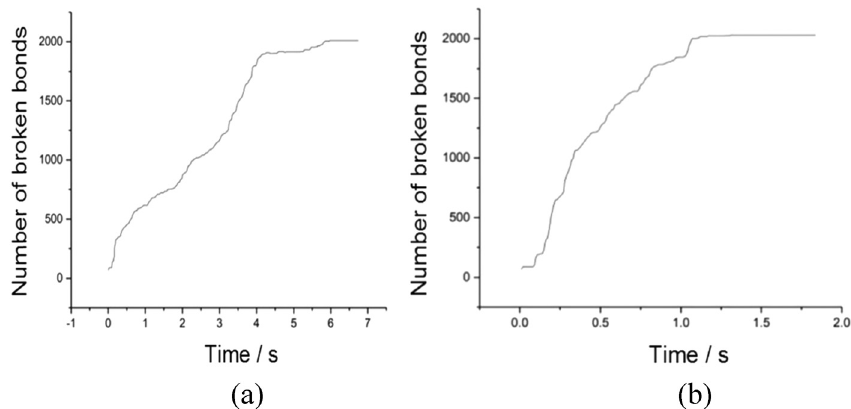
Figure 10: Crushing time comparison chart. ( a ) Before optimization and ( b ) after optimization.